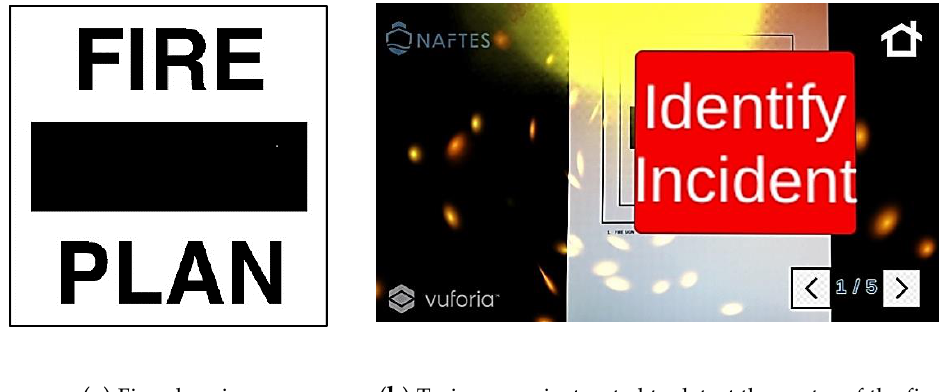
Figure 1. First screen of a scenario of fire on an electrical circuit. ( a ) Printed target sign, and ( b ) the corresponding instructions that appear in the firefighters’ view.